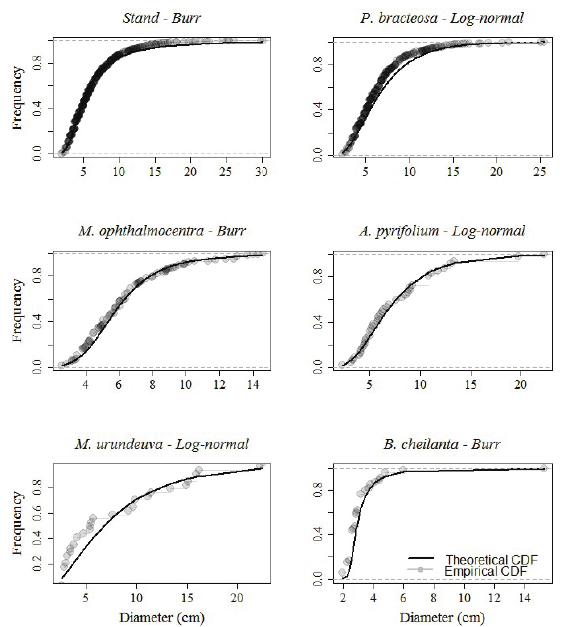
figure 3 – Diameter distributions and fitted curves of the models for the stand and HIV species.